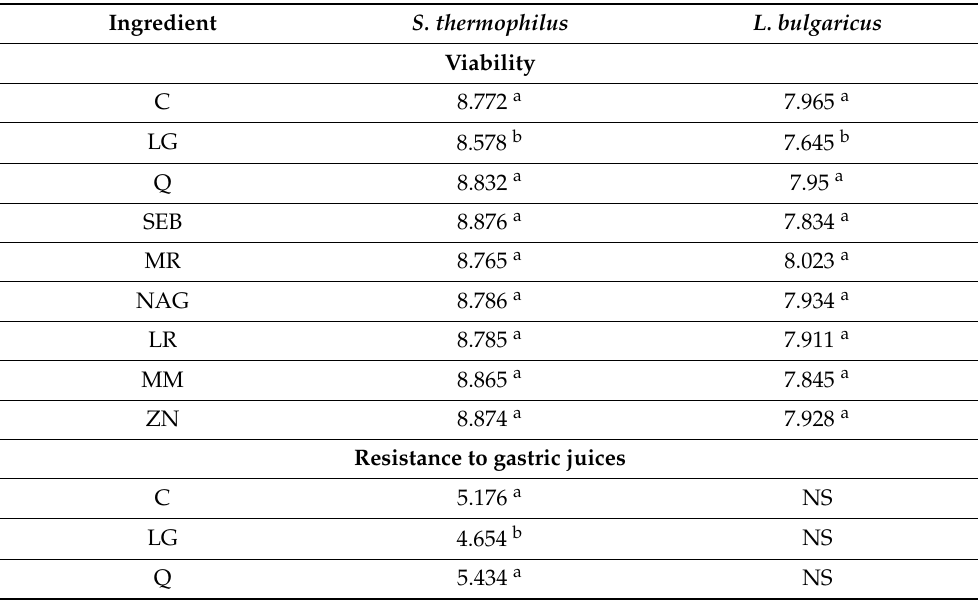
Table 4. Least squares means for viability and gastric juices tolerance of L. bulgaricus and S. ther- mophilus as influenced by